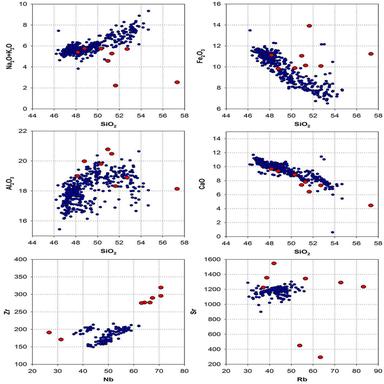
Harker diagrams of selected major and trace elements shown in Composition of ghiara samples (red circles) are compared to recent and historic Etnean volcanics (blue circles). Literature data of the Etnean products are from dataset. (For interpretation of the references to colour in this figure legend, the reader is referred to the web version of this article.)